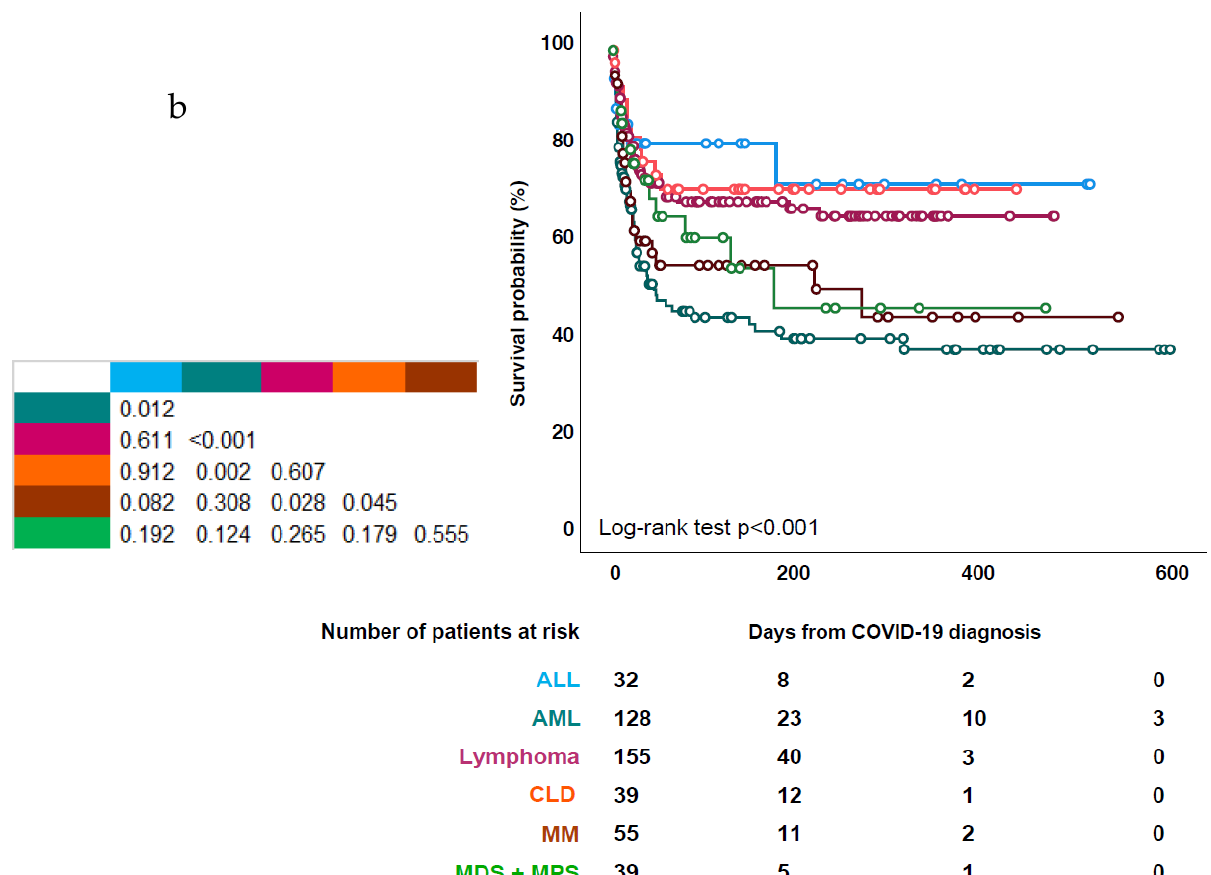
Figure 1. Overall survival probability. ( a ) Cohort. ( b ) Patients by malignancy. Overall, patients treated for HM showed a higher survival probability at 30 days follow-up as compared to those untreated ( p < 0.001) (Figure 2). Higher survival probability in those who were treated was also found in patients with AML ( p < 0.001), lymphoma ( p < 0.001), MDS/MPS ( p = 0.01), and MM ( p = 0.052) (Figure S1).